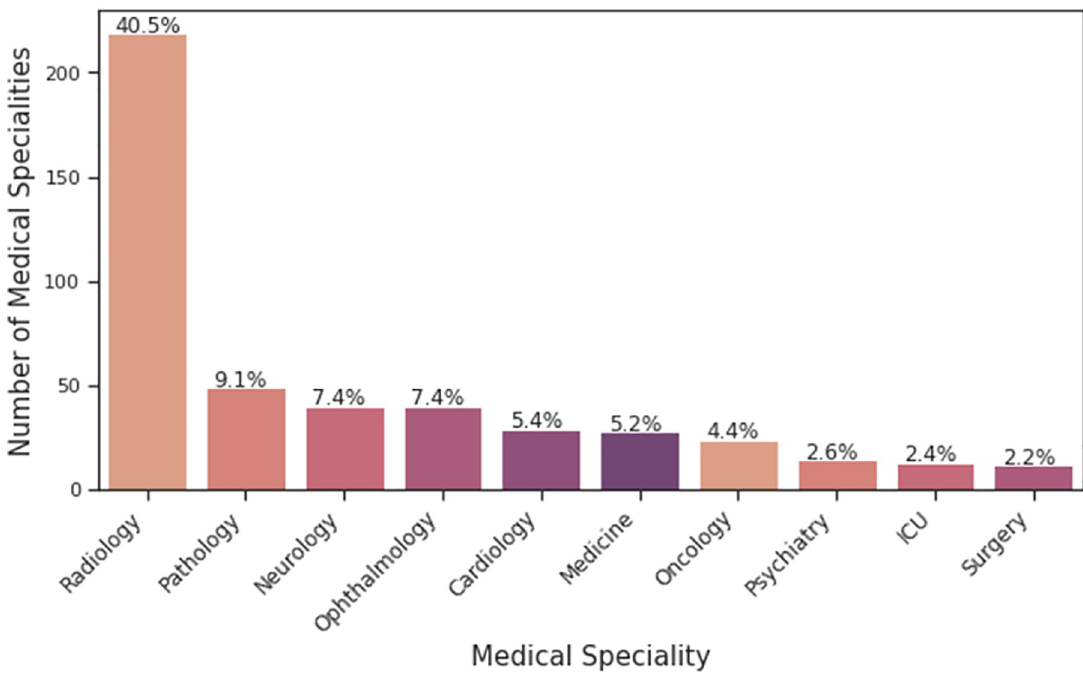
Fig 3. Distribution of overall paper specialty in AI in medicine.